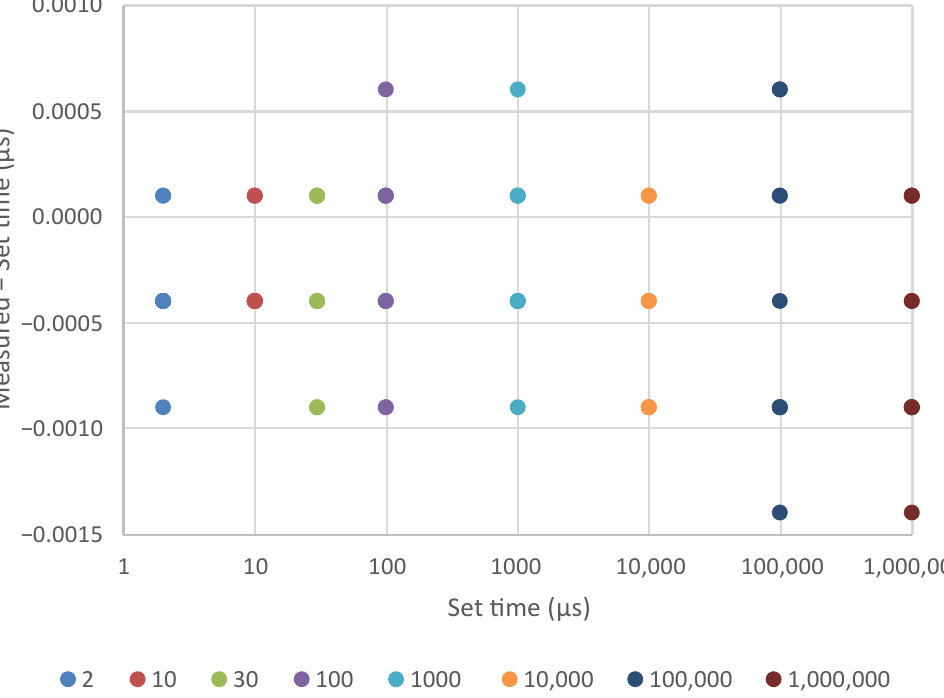
Figure 9. Set of 10 repeated measurements using counter and clamper.